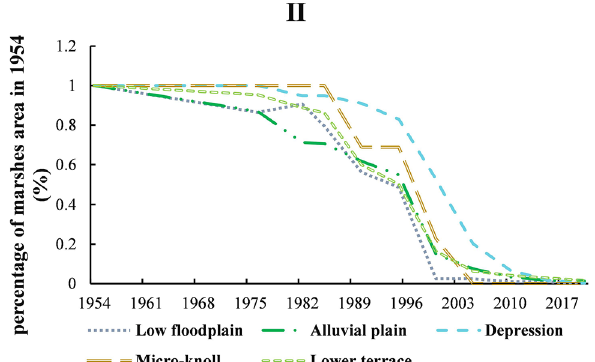
Figure 7. The distribution of marsh during 1954–2020 based on geomorphic types in Nongjiang_Bielahong river. As Figure shown that marshes were mainly distributed on alluvial plains, lower terrace, followed by depressions, and only a few were distributed on low floodplains and few micro-knoll. The reclamation of farmland first started reclamation on alluvial plain and lower terrace, then on low floodplain, followed by depressions, finally micro-knoll.